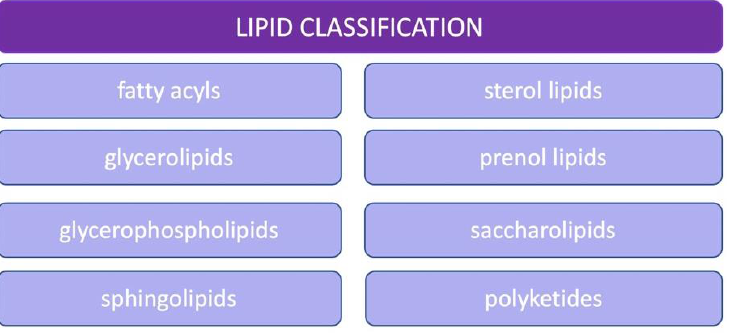
Figure 1. Updated classification of lipids.